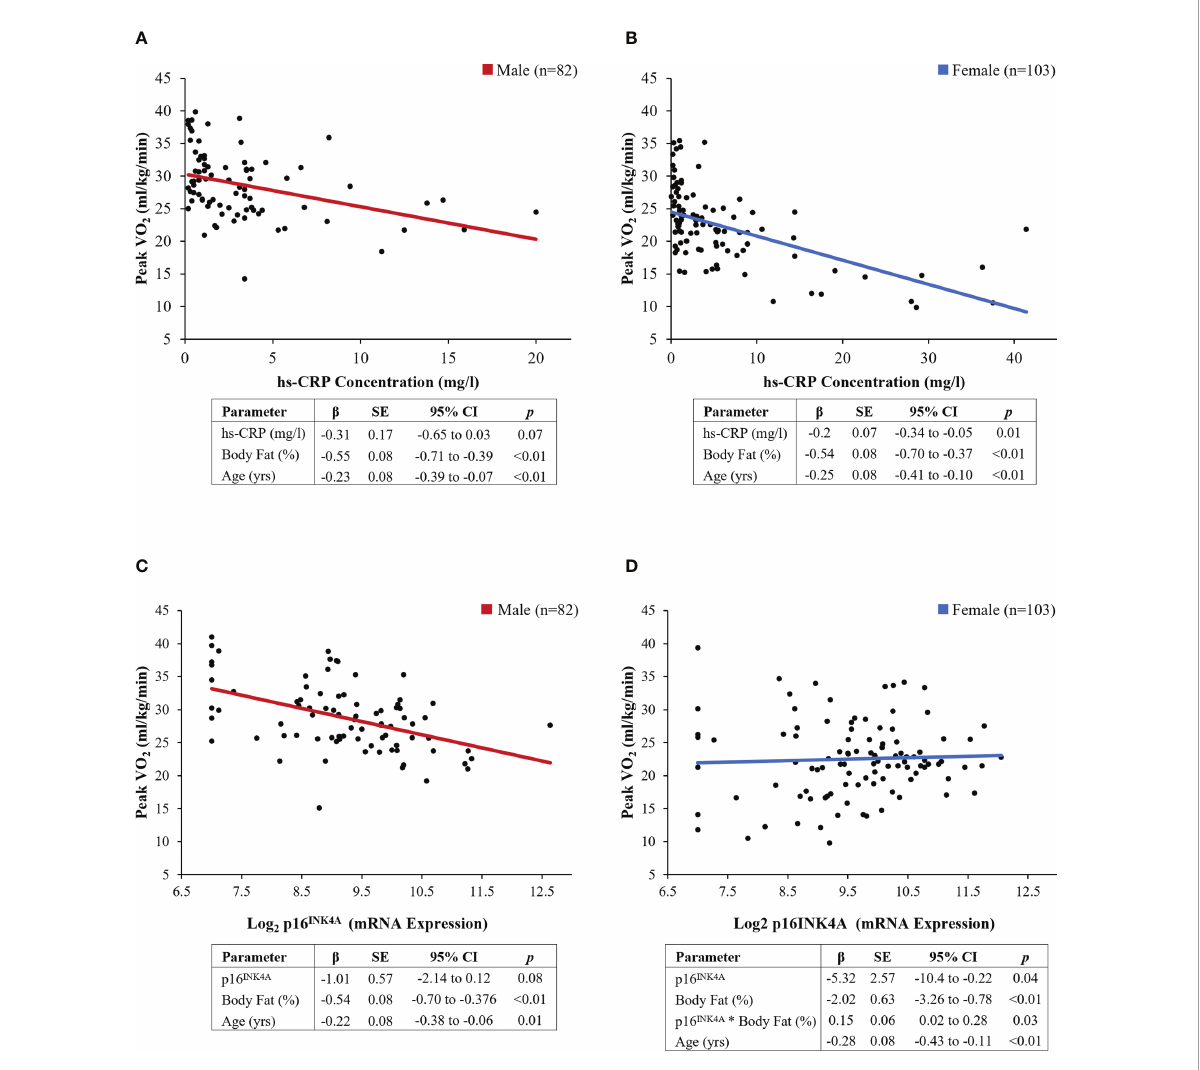
FIGURE 3 Results of sex-strati fi ed multivariable models. (A, B) hs-CRP concentration (mg/L), (C, D) p16 INK4A expression. Regression lines represent the linear associations between individual biomarkers and exercise capacity, adjusted for